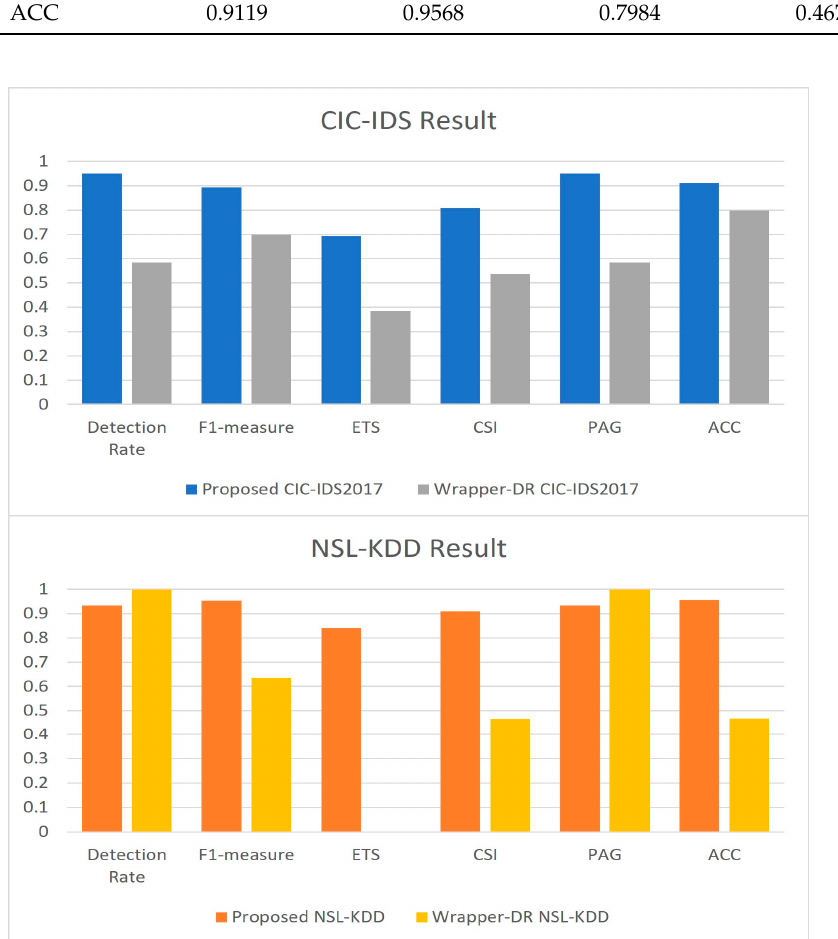
Figure 16. Result of feature selection method (CIC-IDS2017).